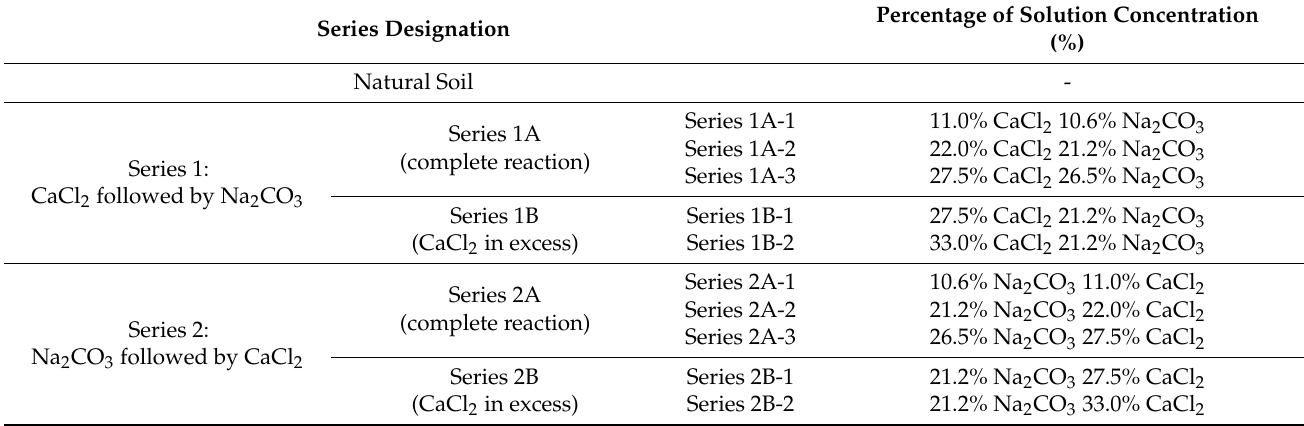
Table 4. Designations and details of mixing method.